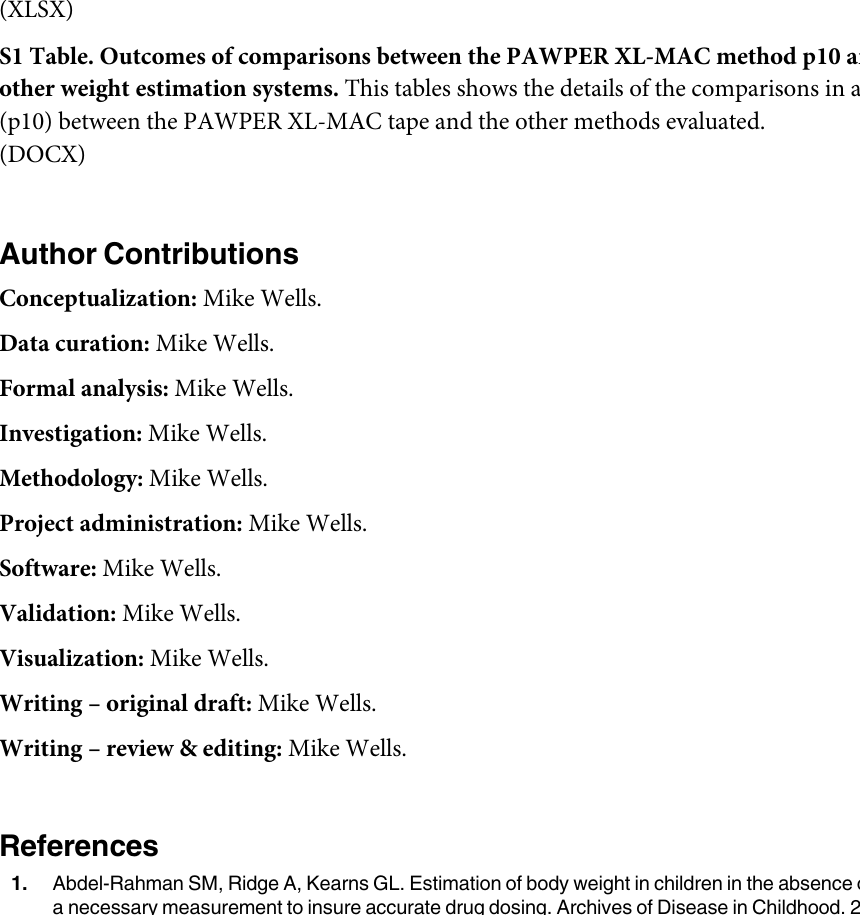
S1 Table. Outcomes of comparisons between the PAWPER XL-MAC method p10 and the other weight estimation systems. This tables shows the details of the comparisons in accuracy (p10) between the PAWPER XL-MAC tape and the other methods